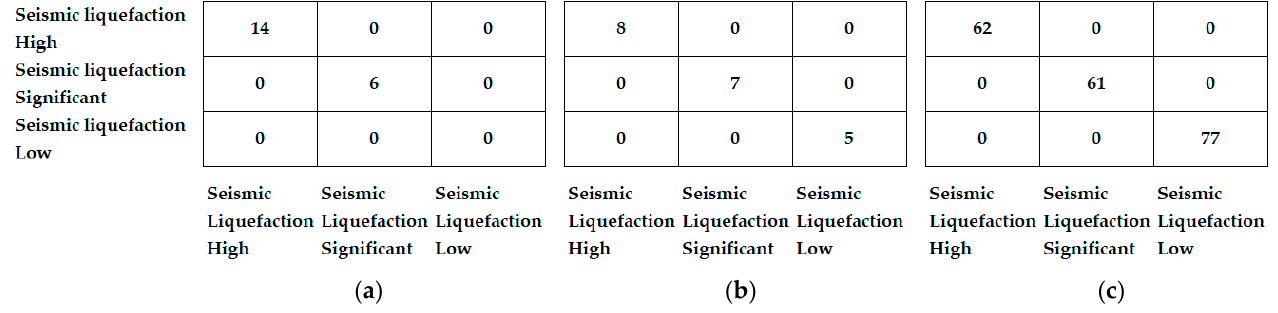
Figure 4. Confusion matrix for the “seismic liquefaction” failure mechanism using the XGBoost model. ( a ) Confusion matrix corresponding to Experiment 1; an absence of “true positive” can be observed for the “low” class due to the imbalance of the classes and the scarcity of information in the data set. ( b ) Confusion matrix corresponding to Experiment 2; it shows an improvement compared to ( a ) when the classes are balanced, and the amount of data is increased by generating using TGAN. ( c ) Confusion matrix corresponding to Experiment 3; by increasing the database, it is possible to have a better test data set, maintaining the good results obtained in Experiment 2.